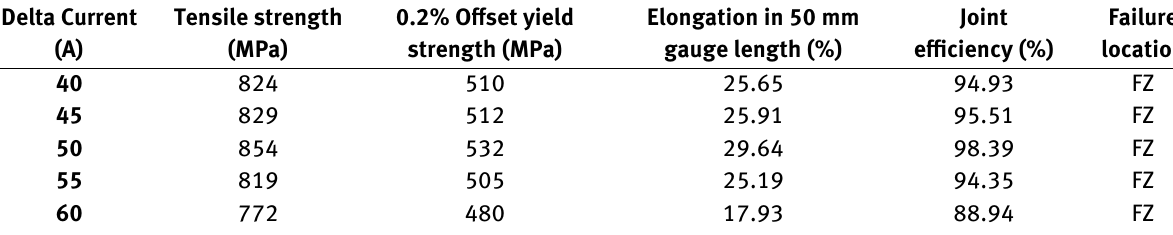
Table 6: Effect of Delta Current on transverse tensile properties of welded joints Delta Current